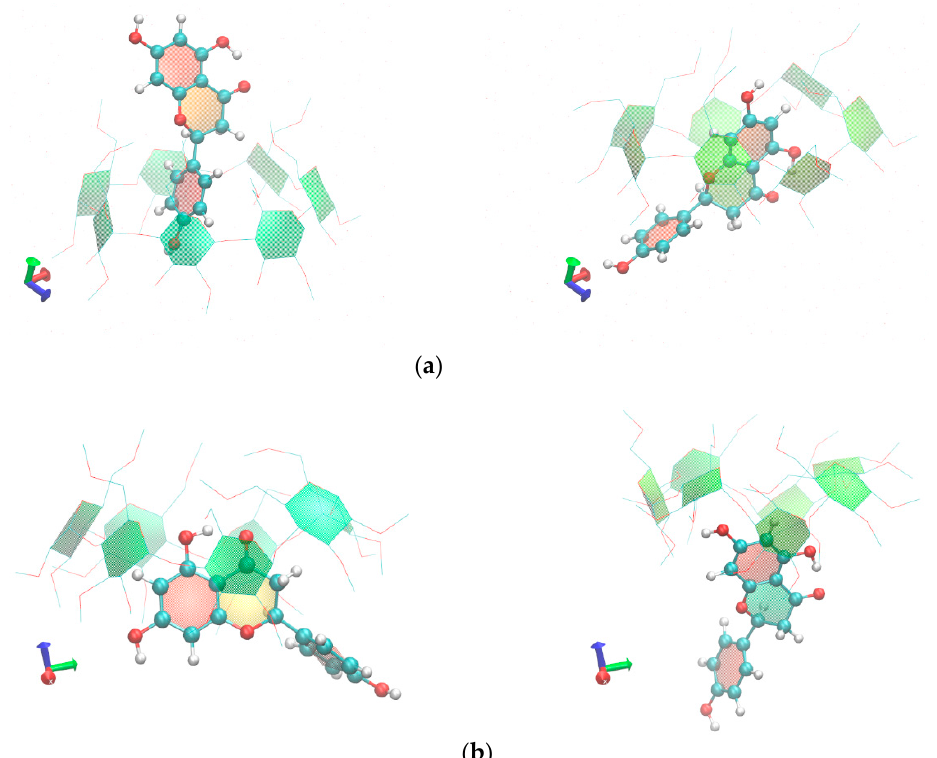
Figure 5. Representative snapshots for ( a ) naringenin / DM- β - CD at: 0 ns (left) and 2 ns (right), and for ( b ) naringenin / TM- β - CD at: 0 ns (left) and 8 ns (right). Guest molecules are depicted as ball-and-stick models and hosts’ macrocycle as a paperchain.